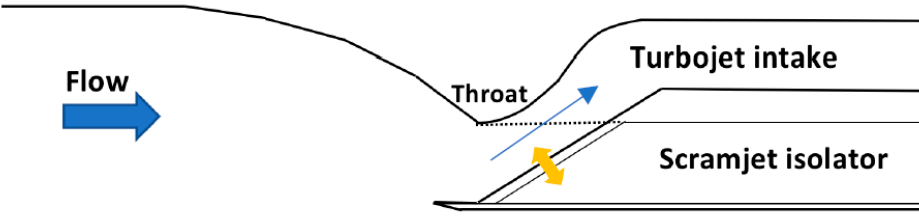
Figure 35. Diagram of the over-under configuration of the scramjet and turbojet engine.